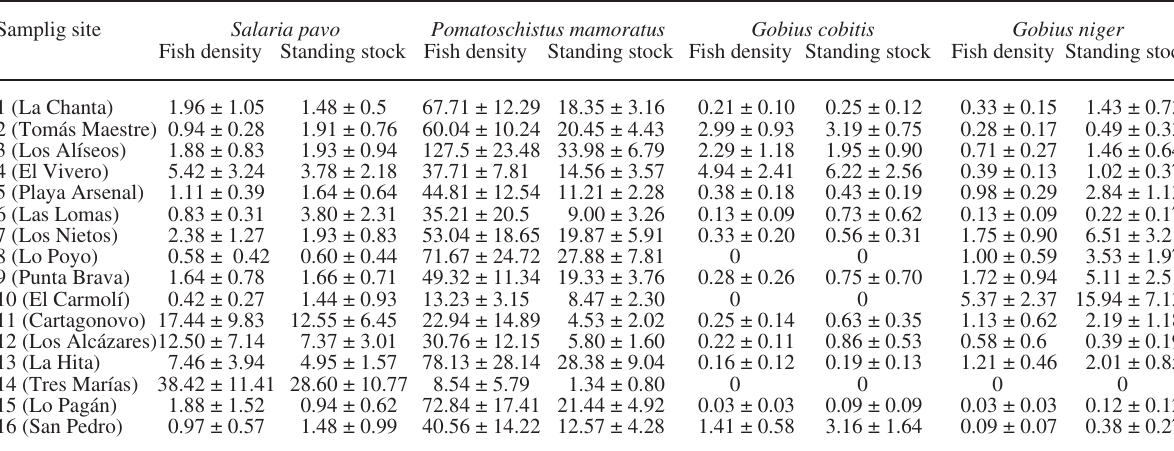
Table 2. − Mean ± S.E. fish density (no. individuals/100 m 2 ) and standing stock (g individuals/100 m 2 ) of the species studied at each sampling site during the study period. Samplig site